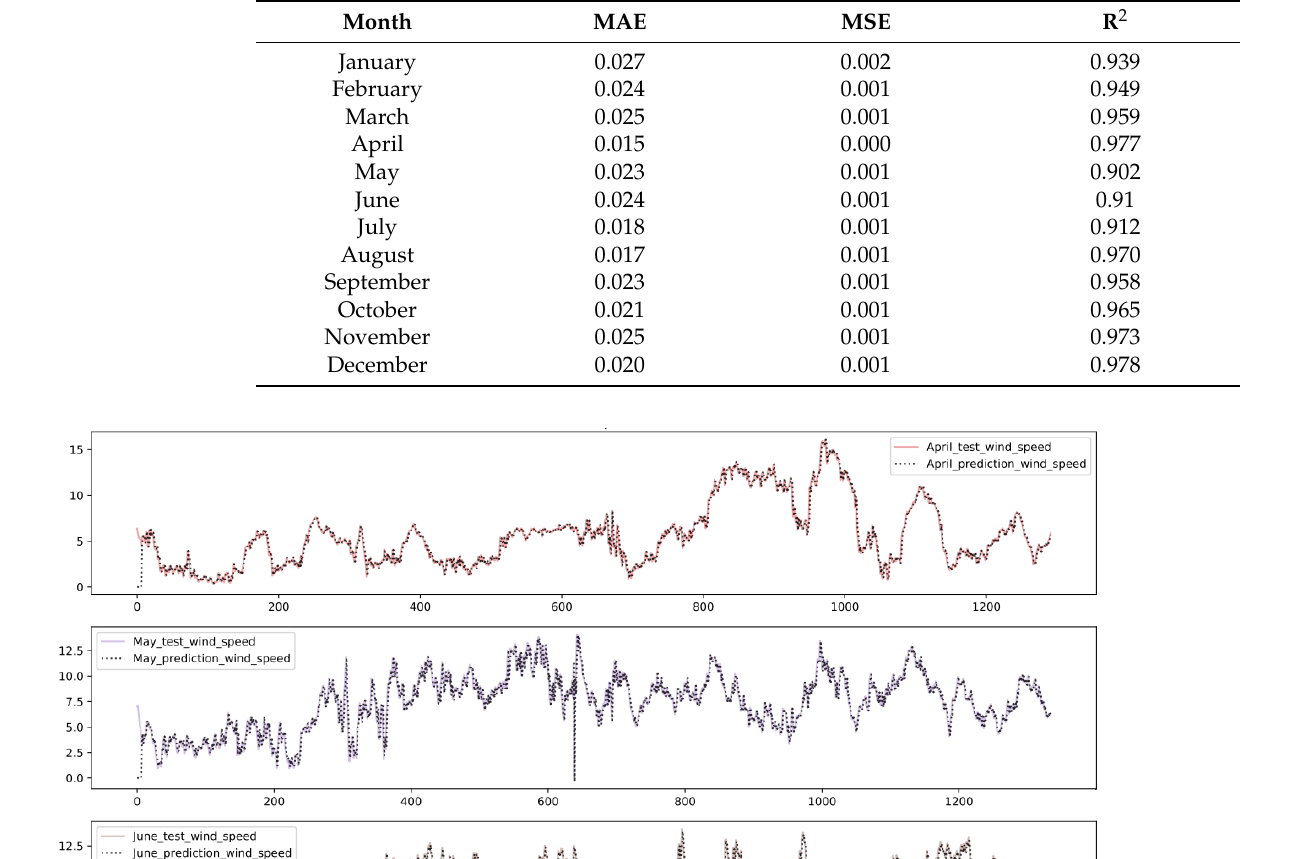
Table 2. The performance measures of wind speed prediction over the test set for whole year.